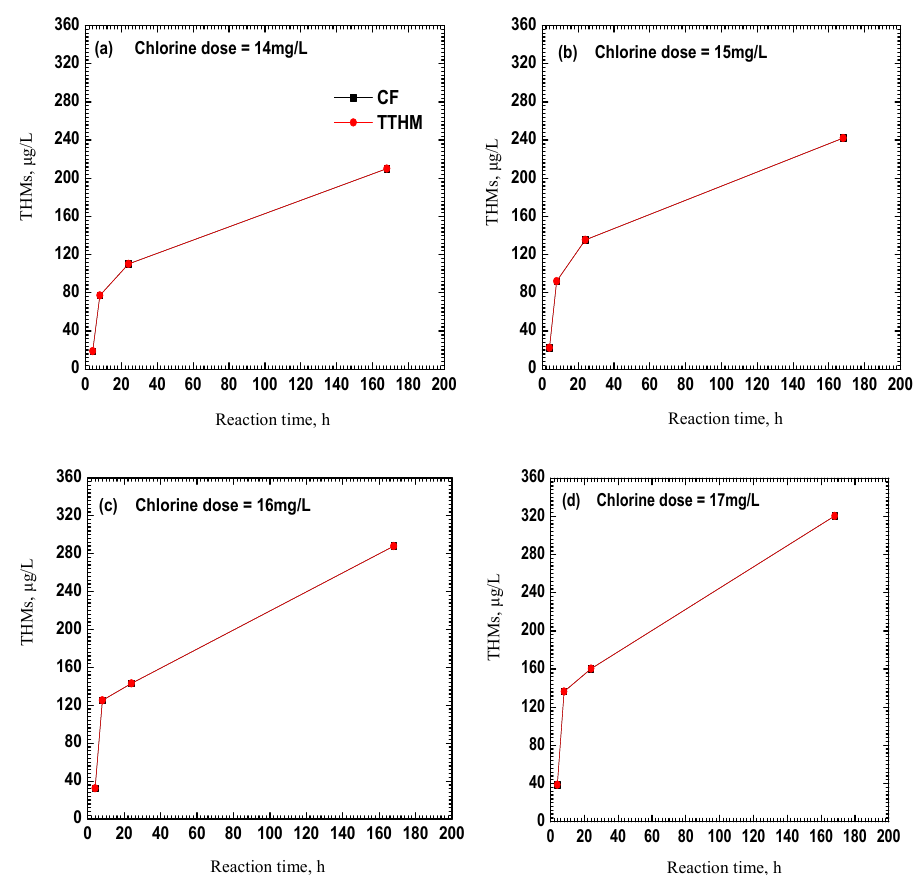
Figure 2. Effect of reaction time on THMs formation at different chlorine doses in the ground water sample collected from Jajmau in January,